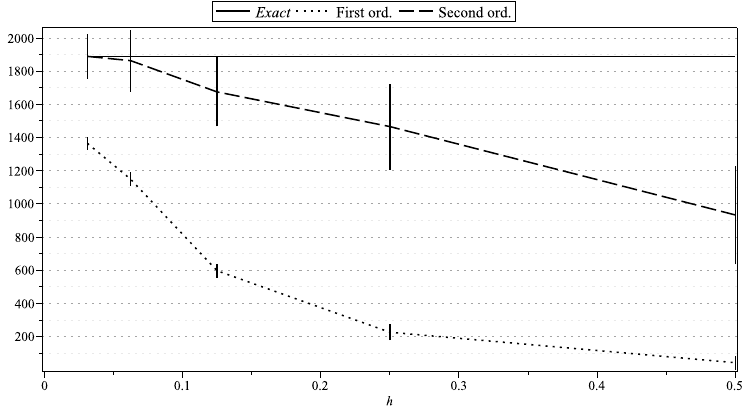
) 5 as functions of h : σ = 0.8, x 1